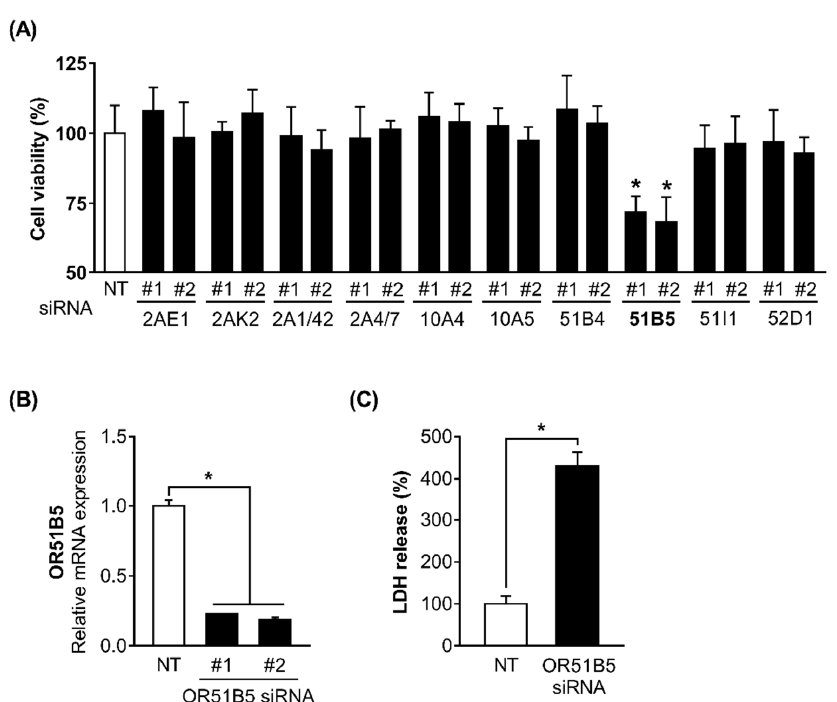
Figure 4. The knockdown of OR51B5 , among the 10 altered OR genes, decreased Hs68 cell viability. ( A ) The cells were transfected with non-targeting small interfering RNA (siRNA; NT) or two distinct siRNAs (#1 and #2) against 10 ORs ( OR2AE1 , OR2AK2 , OR2A1/42 , OR2A4/7 , OR10A4 , OR10A5 , OR51B4 , OR51B5 , OR51I1 , and OR52D1 ) and further incubated for 72 h. Cell viability was analyzed using WST-1 assay. NT or OR51B5 -specific siRNA #1 and #2 were introduced into Hs68 cells and cells were harvested after 72 h. ( B ) OR51B5 mRNA expression and ( C ) cell death were analyzed by quantitative PCR and LDH assay, respectively. The results are expressed as mean ± SEM of three independent experiments. * p < 0.05.